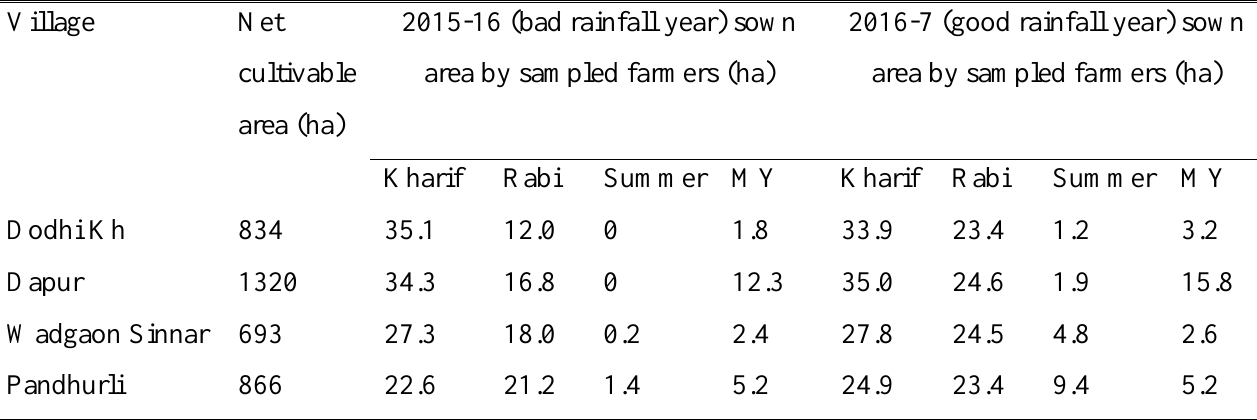
Table A5.1 Comparison of seasonal sown area by sampled farmers in 2015 vs 2016 (same sample farmers in both years). In the drought year of 2015-16, large share of cultivable area was left